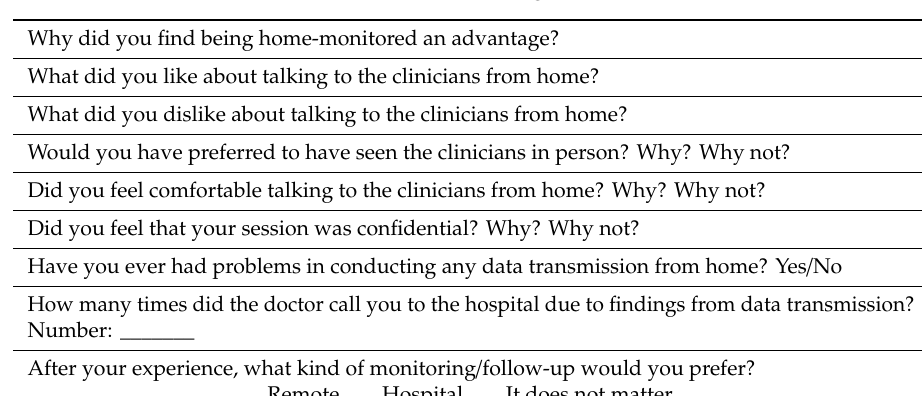
Table 2. Interview